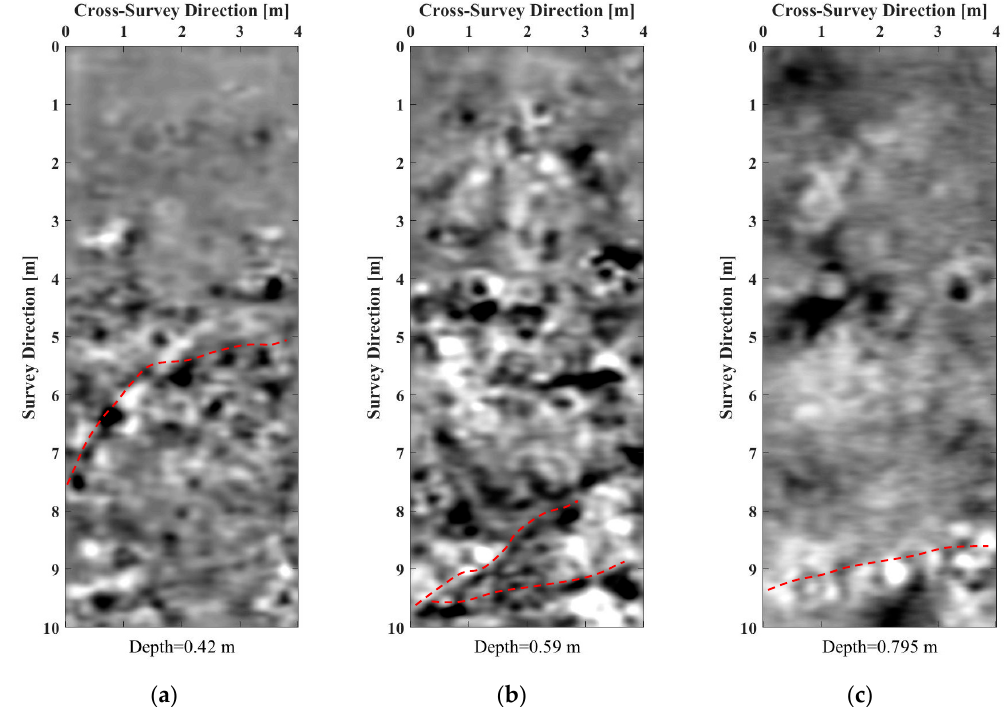
Figure 9. Migrated horizontal slices at di ff erent depths. Red lines indicate the detected roots in the migrated data set. ( a ) Migrated slice at 42-cm depth; ( b ) migrated slice at 59-cm depth; ( c ) migrated slice at 79.5-cm